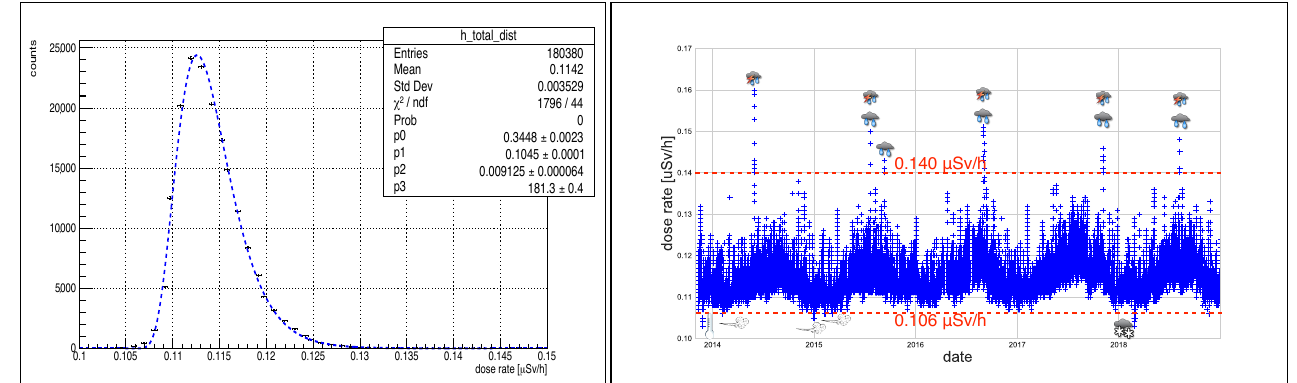
Figure 4. ( Left ) Cross sectional distribution of the dose rate data acquired every 15 min and the log- normal fit (blue dashed line, color on-line). ( Right ) dose rate time-series showing the meteorological events that are the source of the